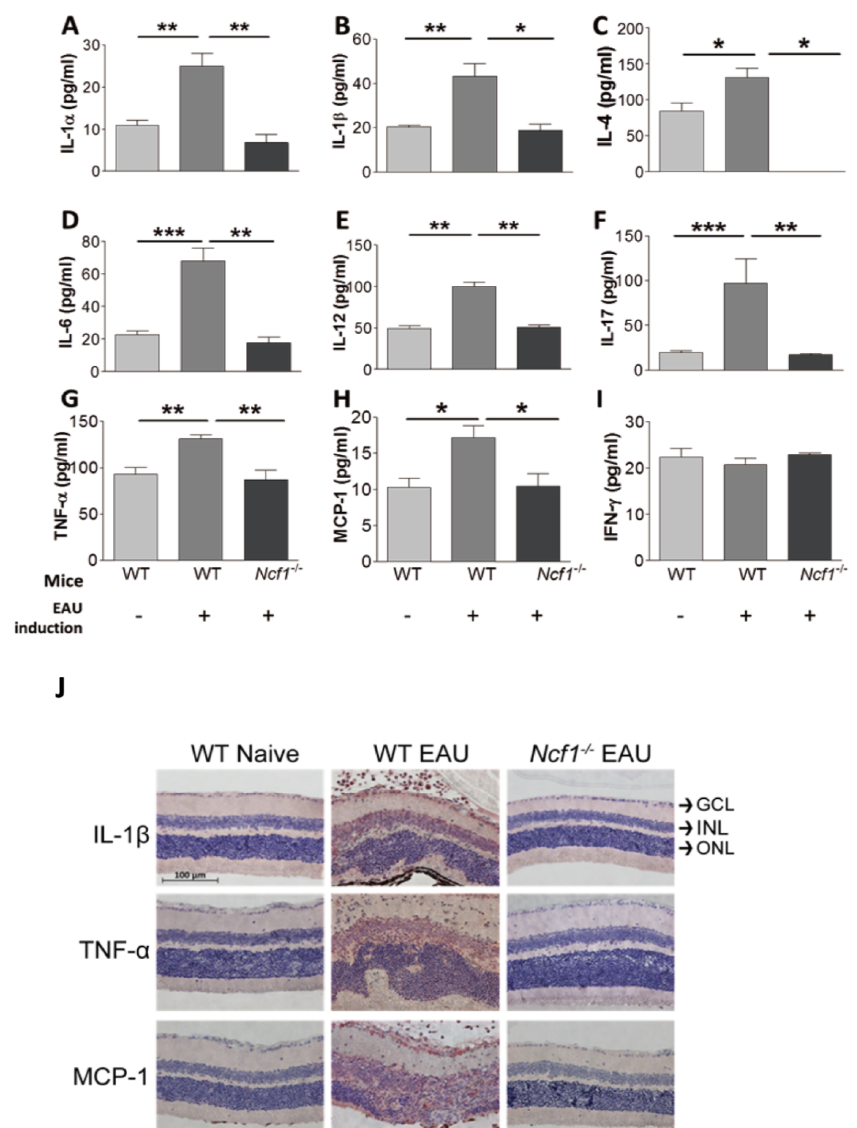
Figure 3. The influence of Ncf1 deficiency on the levels of inflammatory mediators in the retinas of mice with EAU induction. Levels of interleukin (IL)-1 α ( A ), IL-1 β ( B ), IL-4 ( C ), IL-6 ( D ), IL-12 ( E ), IL-17 ( F ), tumor necrosis factor (TNF)- α ( G ), monocyte chemoattractant protein (MCP)-1 ( H ), and interferon (IFN)- γ ( I ) in the retinas of wild-type (WT) and Ncf1 − / − mice with ( + ) or without (-) EAU induction are shown. Data show the mean + SE values (error bars) of at least five samples per group. * p < 0.05, ** p < 0.005, *** p < 0.001. ( J ) Eyes of WT and Ncf1 − / − mice without (naïve) or with EAU induction were subjected to staining for the indicated inflammatory mediators. The retina portion is shown. Images are representative of at least four samples per group from two independent experiments. GCL, ganglion cell layer; INL, inner nuclear layer; ONL, outer nuclear